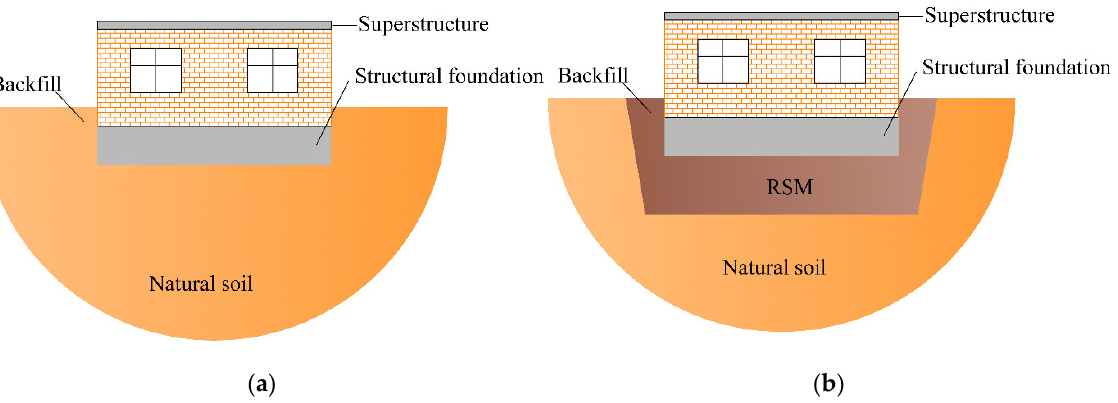
Figure 1. Schematic diagram of the GSI–RSM system: ( a ) without GSI–RSM system; ( b ) with GSI– RSM system.